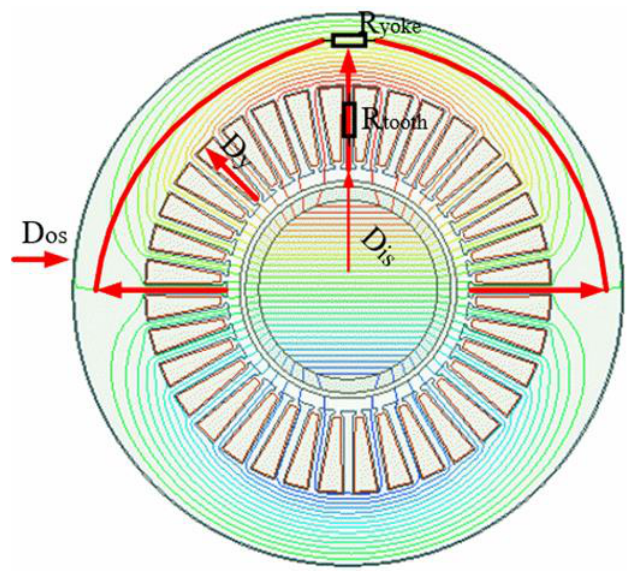
Figure 3. Equipotential lines of the magnetic circuit.